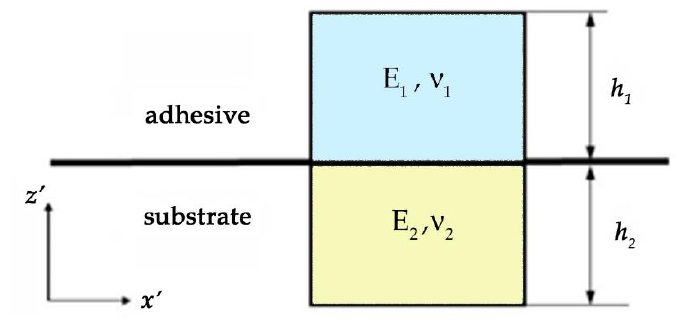
Figure 5. The selected microvolume at the interface.